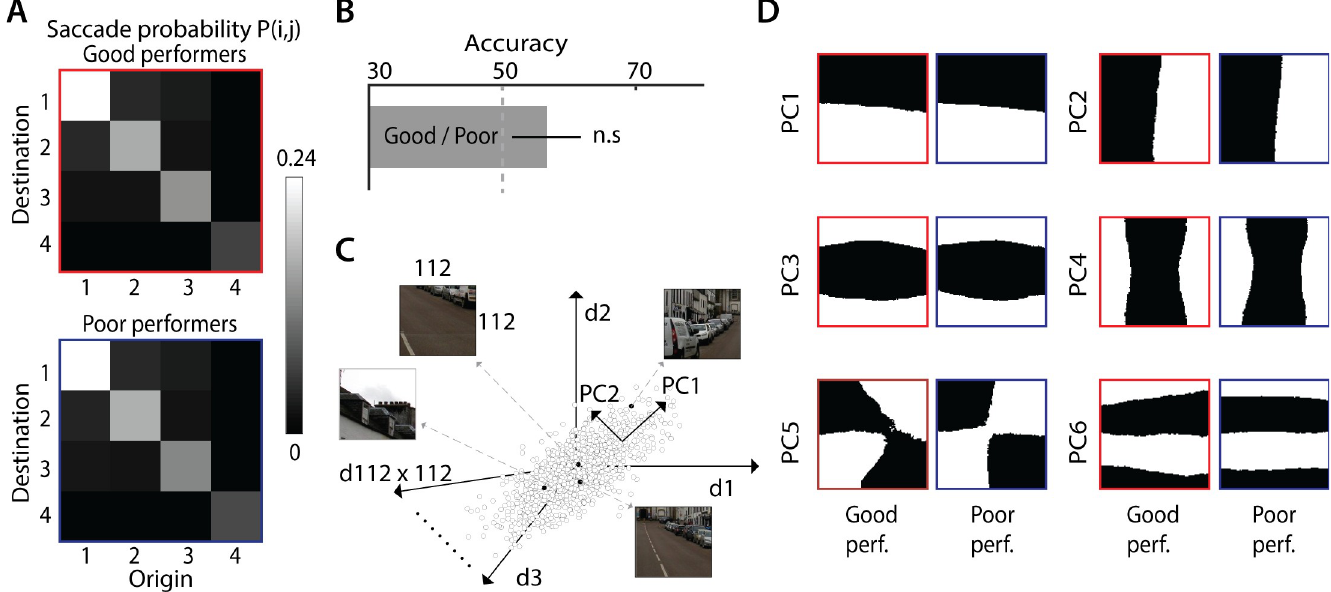
Fig 3. Saccade probabilities and fixated features are similar across good and poor performers. A. Average saccade probability matrices for the good performers (top; red outline) and poor performers (bottom; blue outline). These correspond to probabilities of making a saccade between different “domains” (1–4), each corresponding to a (non-contiguous) collection of image regions, ordered by frequency of fixations: most fixated regions (domain 1) to least fixated regions (domain 4). Cell (I, j) (row, column) of each matrix indicates the probability of saccades from domain j to domain i. B. Classification accuracy for classifying good versus poor performers based on the saccade probability matrix features, using a support vector machine classifier. Other conventions are as in Fig 1D. Error bars: s.e.m. C. Identifying low-level fixated features across good and poor performers. 112x112 image patches were extracted, centered around each fixation, for each participant; each point in the 112x112 dimensional space represents one such image patch. Principal component analysis (PCA) was performed to identify low-level spatial features explaining maximum variance among the fixated image patches, separately for good and poor performers. D. Top 6 principal components, ranked by proportion of variance explained, corresponding to spatial features explaining greatest variance explained across fixations, for good performers (left panels) and poor performers (right panels). These spatial features were highly correlated across good and poor performers (median r = 0.20, p < 0.001, across n = 150 components).